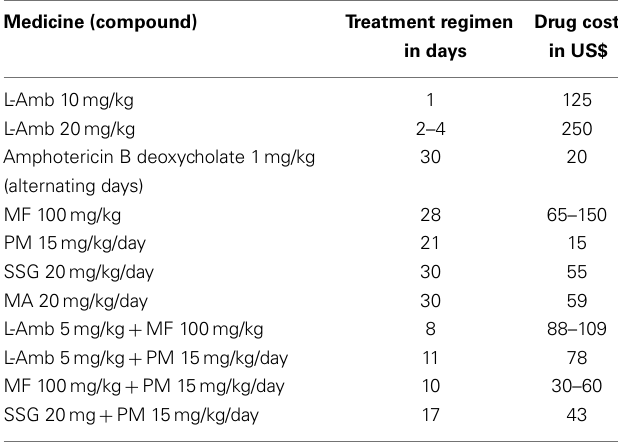
Table 2 | Cost of visceral leishmaniasis treatment (patient weighing 35kg)*